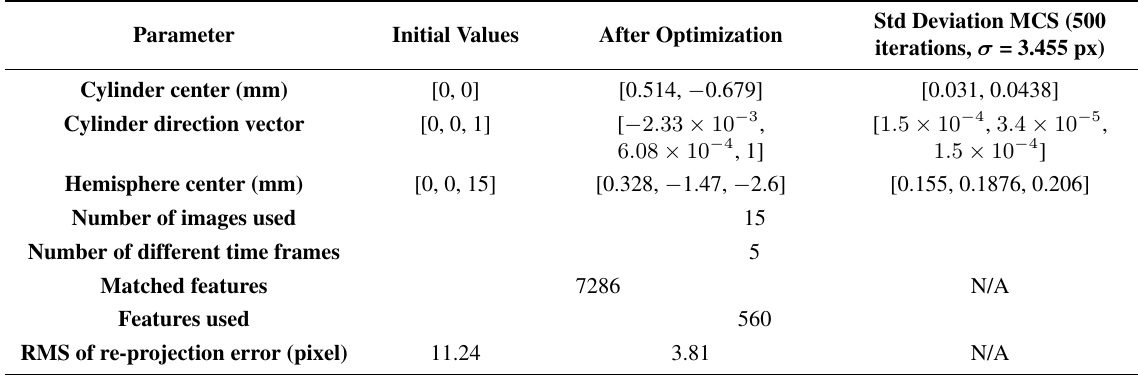
Table 5. Initial and refined values of the housing parameter optimization and results of the Monte-Carlo Simulation